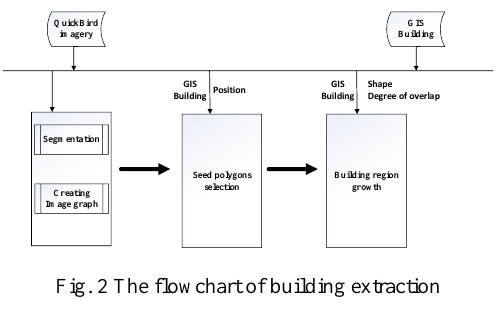
Fig. 2 The flowchart of building